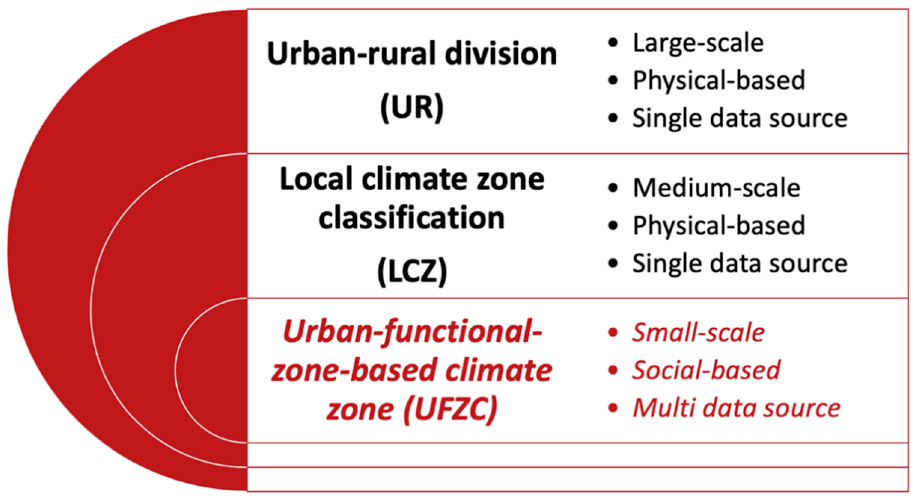
Figure 7. A brief overview of the understanding of the urban temperature (and urban heat island (UHI)) classification and comparison of urban–rural (UR), local climate zone (LCZ), and UFZC system.